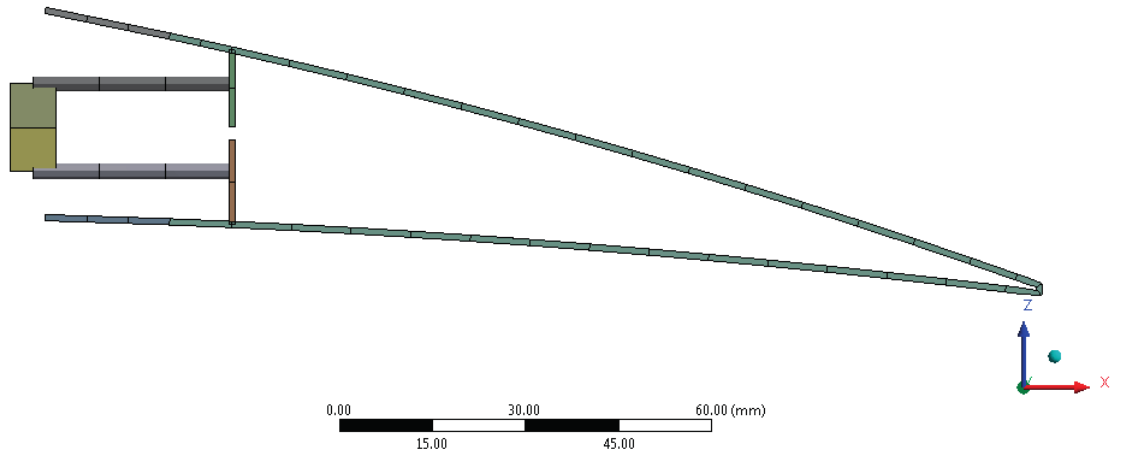
Figure 14. Side view of the generated mesh for open cell